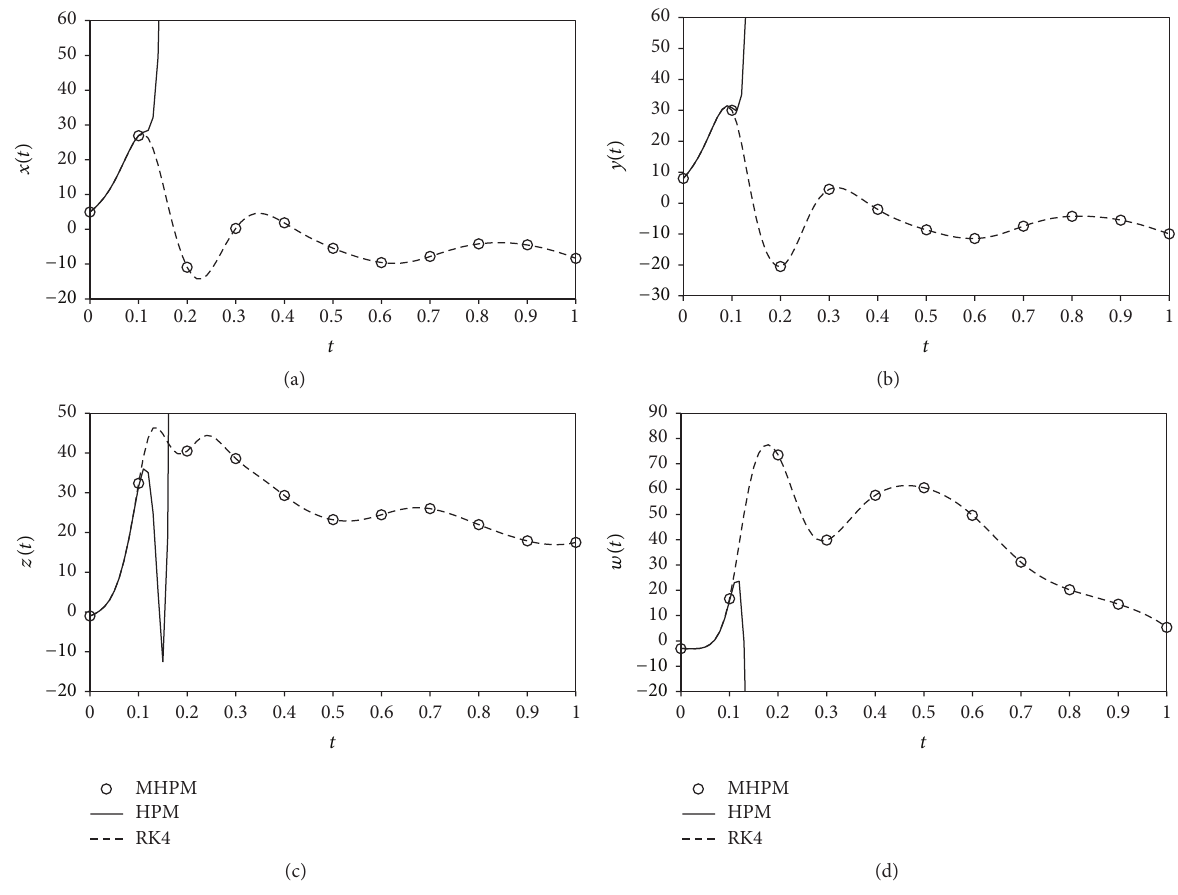
Figure 5: Comparison among 15-term HPM (solid line), MHPM (circle), and RK4 (dash line) for Case (2) of hyperchaotic L¨u